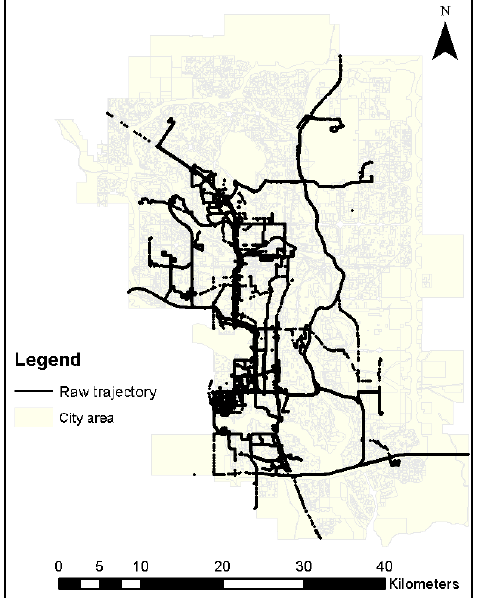
Figure 6. Routes used by user in his history data.